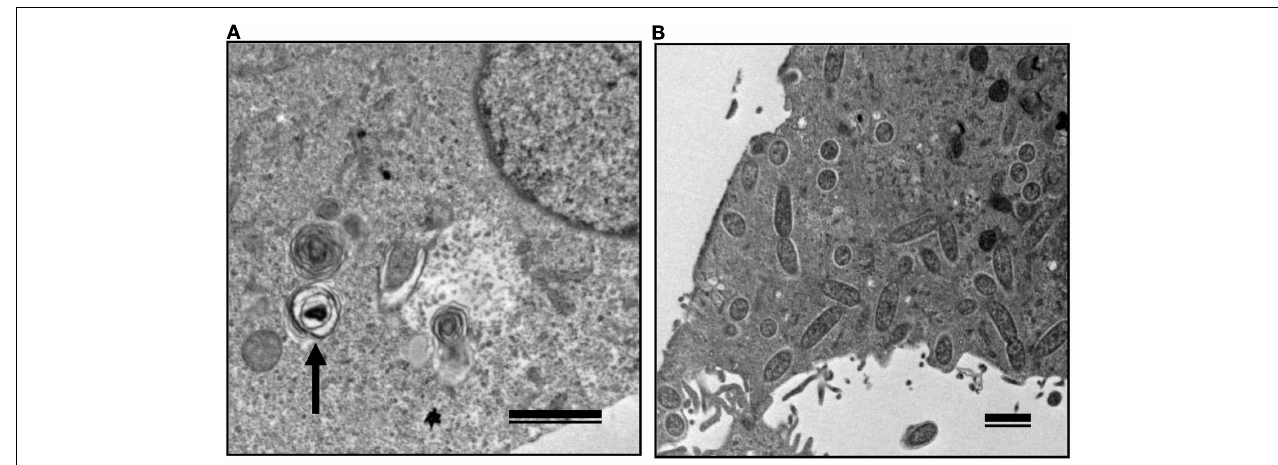
montanensis -infected cells were superinfected with R. japonica on day three of infection and observed at 7days after the first infection. Many free rickettsiae around 1 µ m in length surrounded by halos and those in the course of binary fission were seen in the cytoplasm. Bars, 1 µ